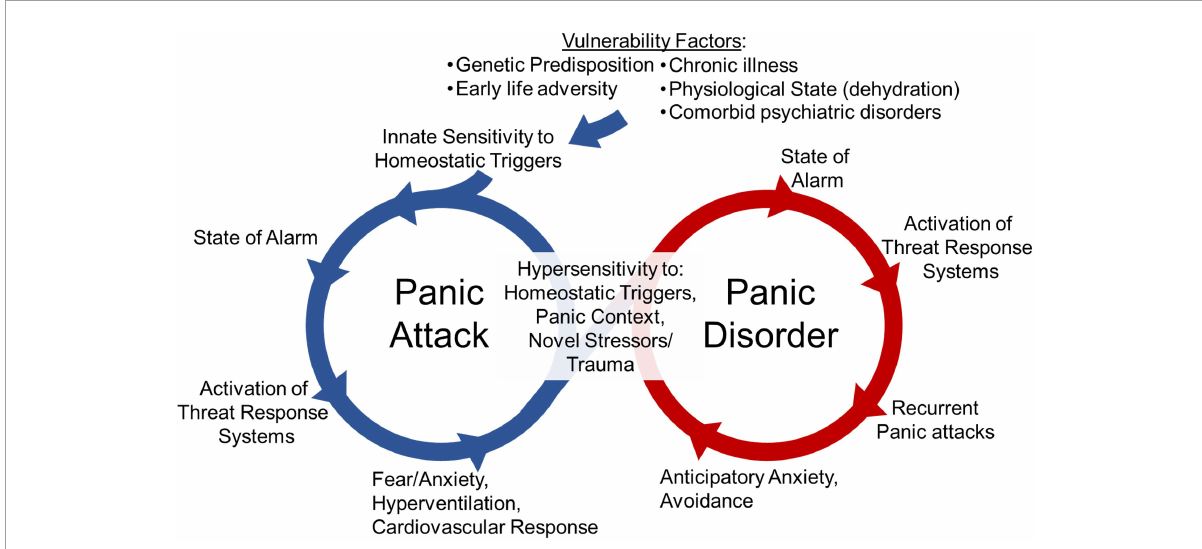
FIGURE1 The cycle of panic disorder: Vulnerability factors such as genetic predisposition, early life adversity, chronic illness, physiological state (i.e., dehydration), or other psychiatric disorder diagnosis associate with innate sensitivity to homeostatic triggers. These homeostatic triggers are threats to internal homeostasis that lead to a heightened state of alarm, the activation of threat responses systems and a panic attack. The emotional, behavioral and physiological responses occurring during panic attacks such as fear, anxiety, hyperventilation and cardiovascular responses are evoked in an effort restore physiological homeostasis. The engagement of these systems and the conditioned responses to contexts where panic attacks occurred can lead to hypersensitivity to future homeostatic triggers, novel stressors or trauma, and exposure to previous panic contexts. This can lead to a cycle of recurrent panic attacks, and anticipatory anxiety and avoidance of panic-associated contexts, that ultimately facilitates the development of panic